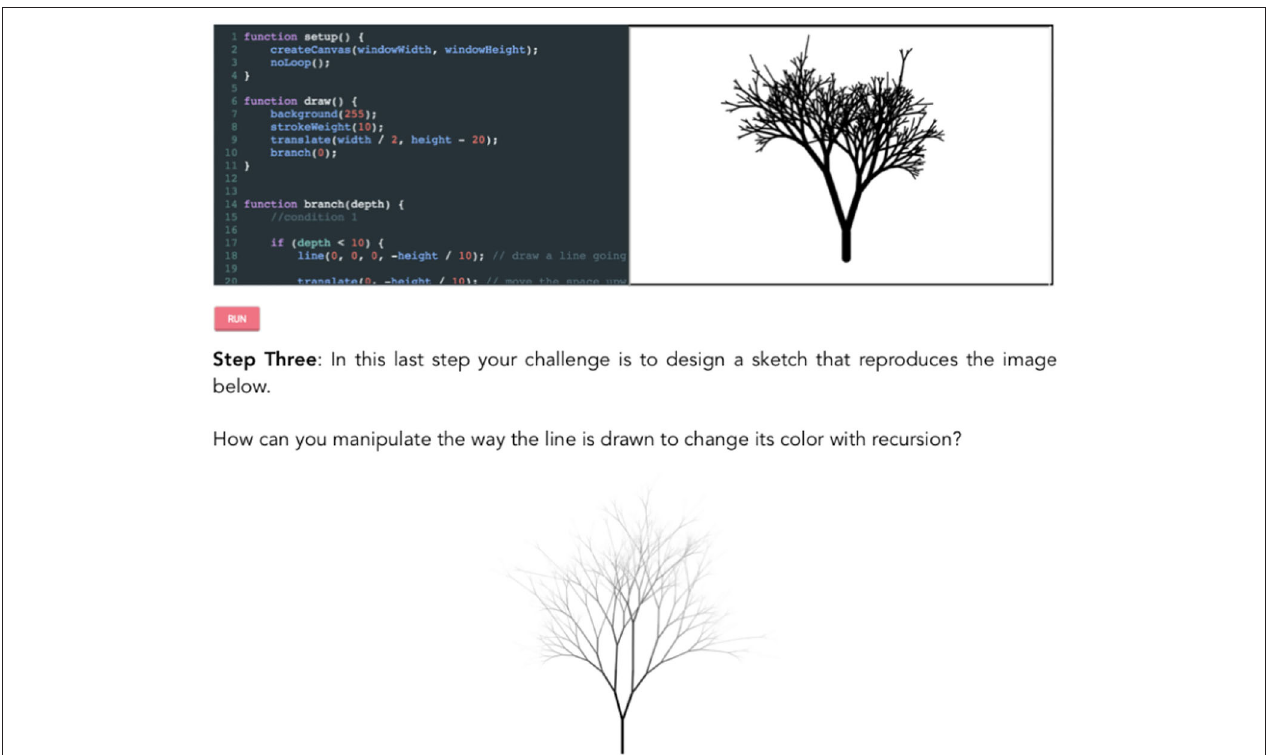
FIGURE 1 | An example challenge from our initial tech probes. Apart from minor advances to the editor (e.g., console access, stack traces) and some cosmetic updates, the structure of each challenge’s page remained largely unchanged throughout the